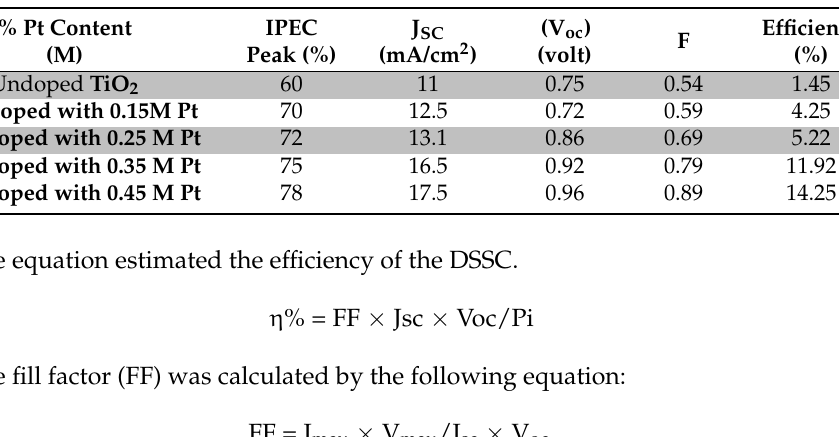
Figure 7. Current density versus photovoltage of undoped TiO 2 and Pt-doped TiO 2 at different molar concentrations. Table 1. Electrical and optical parameters of